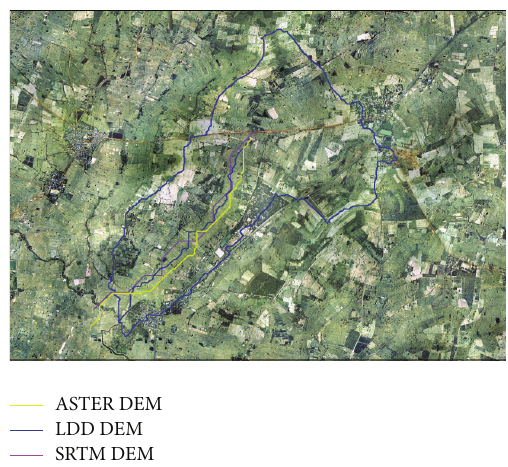
Figure 7: Stream lengths extracted from DEMs of Huai-Por-Phan watershed. Table 7: Size of area extracted from DEM of Huai-Sai-Bath